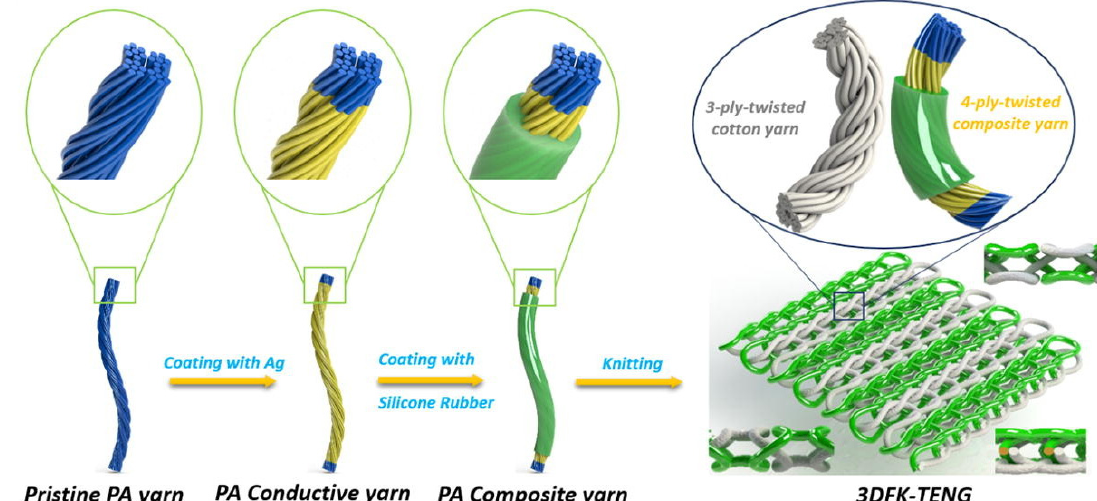
Figure 8. Example of recent developments toward triboelectric energy harvesting materials and structures for textile application: 3D TENG composed of a double-faced interlock knit containing polyamide (PA) 66 yarns coated with silver and silicone rubber and cotton yarns (reproduced from [112], with permission from Elsevier).